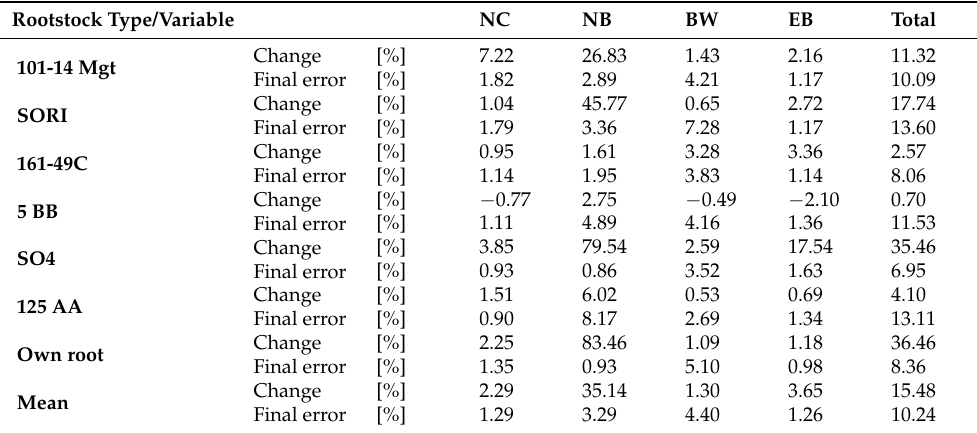
Table 6. Results of model benchmark for all variables and